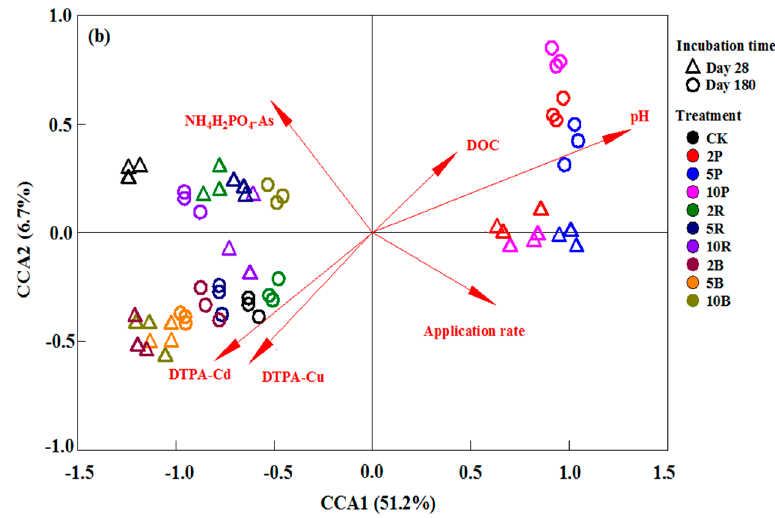
Figure 5. Canonical correspondence analysis (CCA) of soil urease activity ( a ) and catalase activity ( b ) with phosphate, red mud, and biochar after 180 days of incubation (CK: control; 2P: 2% phosphate; 5P: 5% phosphate; 10P: 10% phosphate; 2R: 2% red mud; 5R: 5% red mud; 10R: 10% red mud; 2B: 2% biochar; 5B: 5% biochar; 10B: 10% biochar).